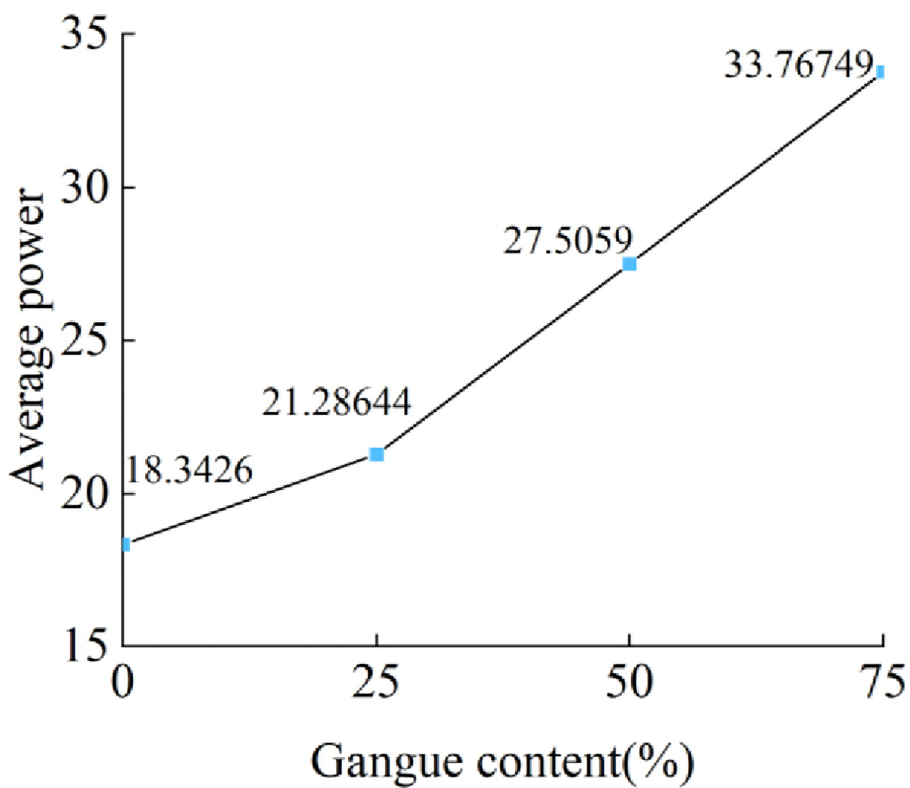
Fig 15. Gangue content versus the average value of the